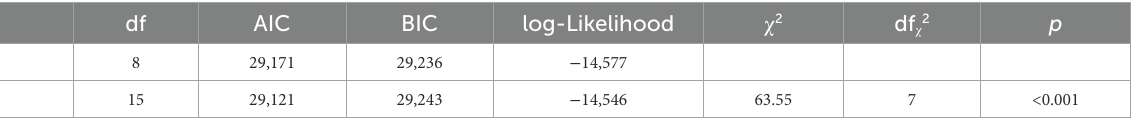
TABLE 2 Models’ comparison with anova